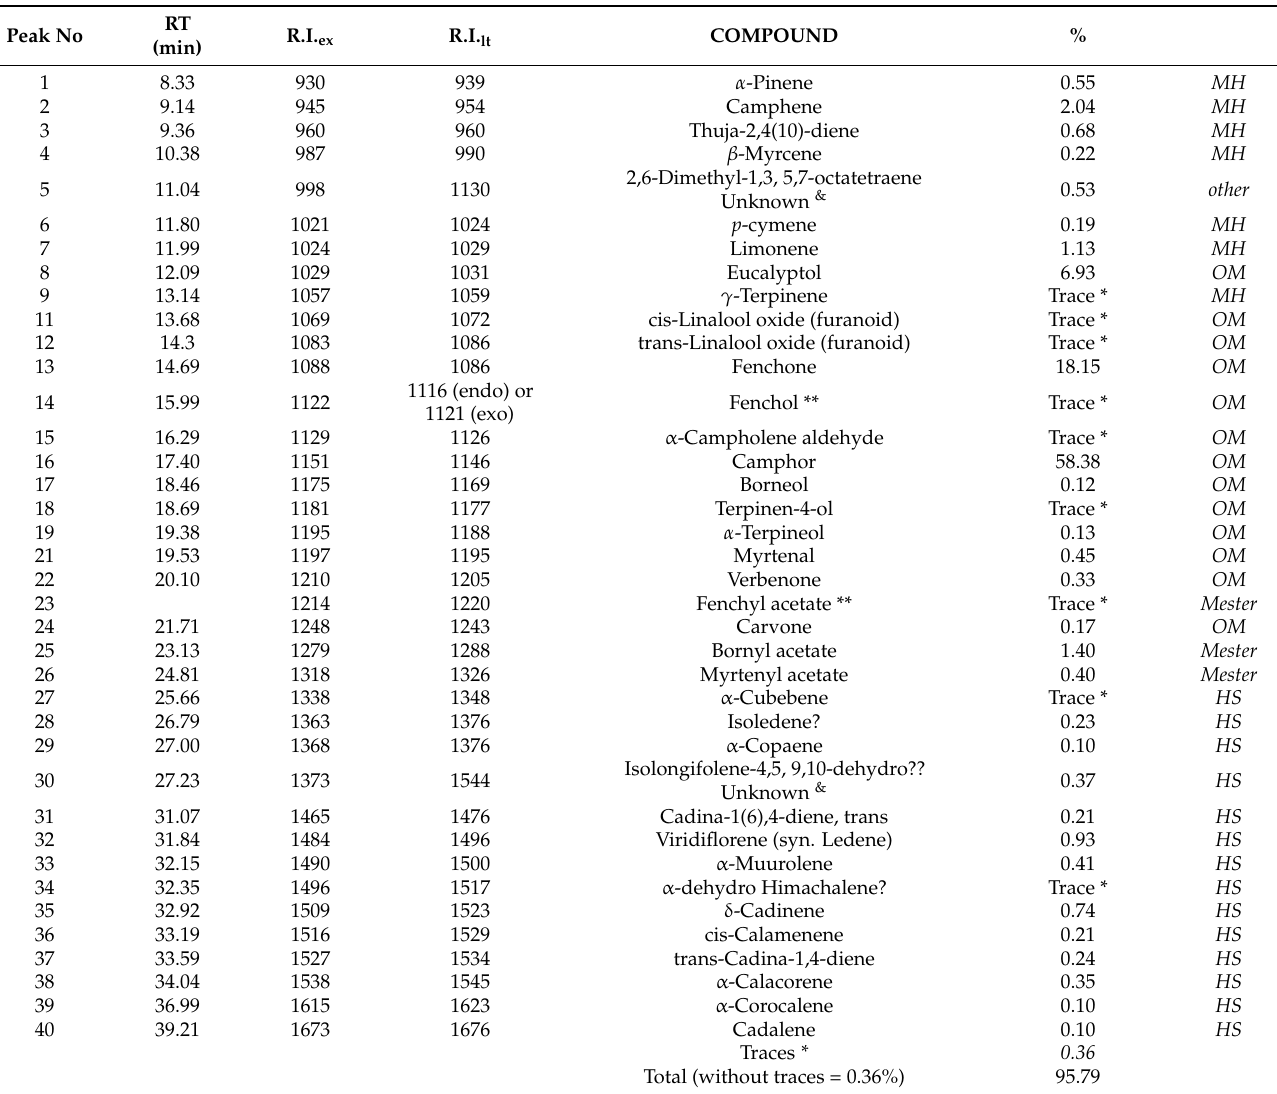
Table 1. Chemical composition of the essential oil of Lavandula stoechas